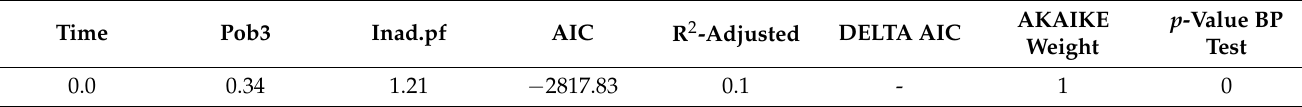
Table 6. Results of panel data models with fixed effects.